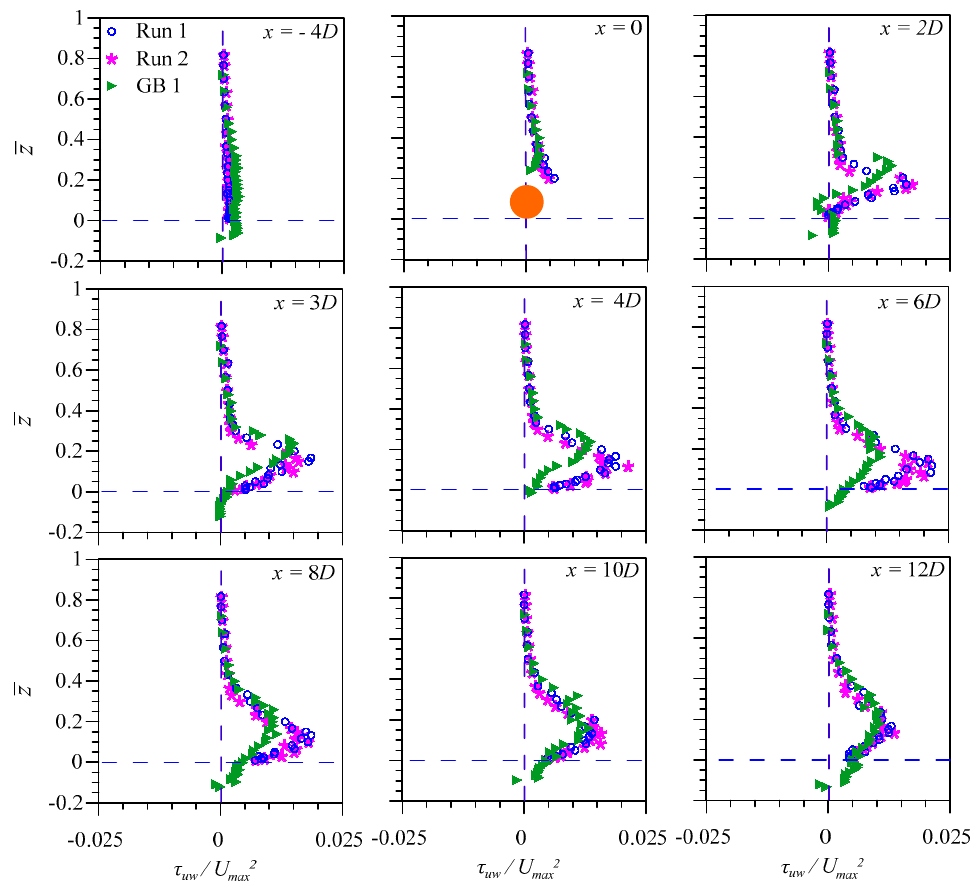
Figure 10. The vertical profiles of normalized RSS ( τ uw / U max 2 ) at different measuring stations ( x ) for Run 1, Run 2, and GB 1.